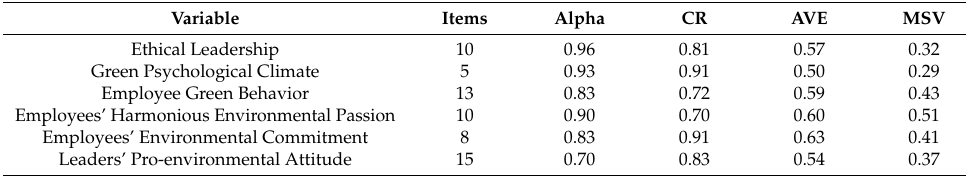
Table 1. Reliability and validity of scales.